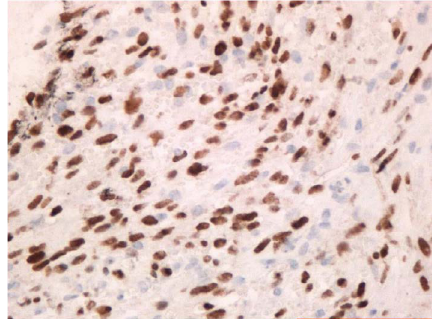
Figure 3. High power view (400x) of Oral Kaposi’s Sarcoma showing a positive immunohistochemistry stain for HHV-8.